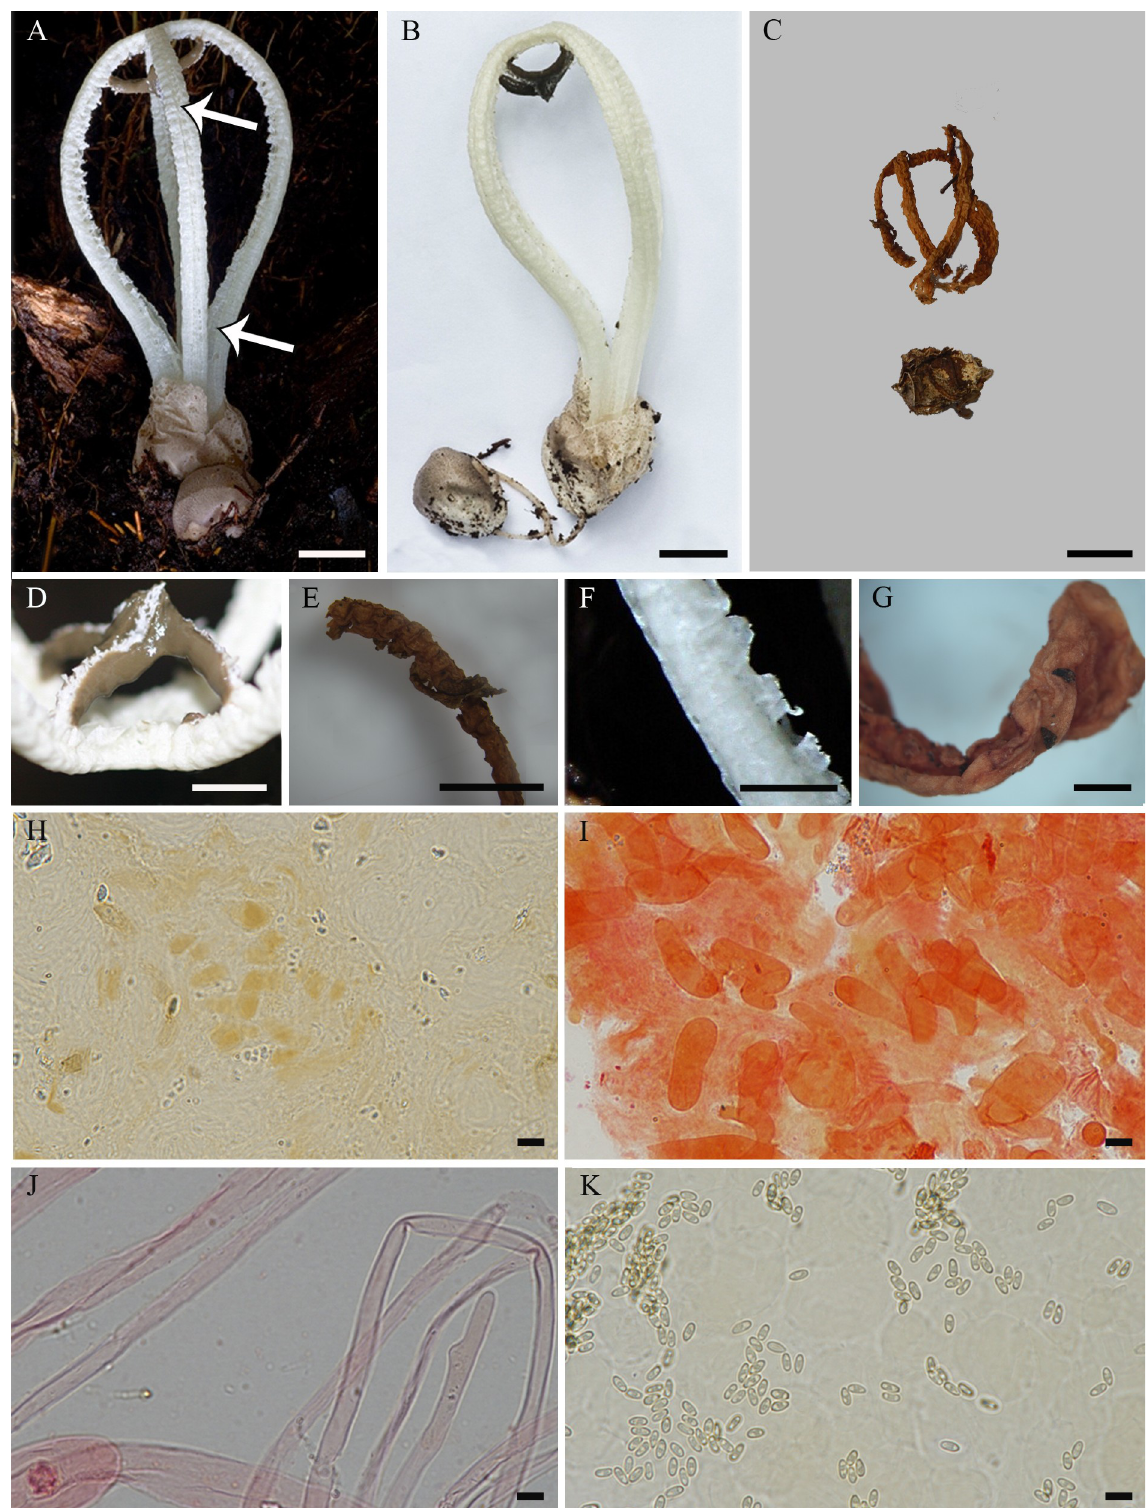
Fig 6. Blumenavia crucis-hellenicae sp. nov. (A, B) Fresh basidiomata, SMDB 18116, holotype. (C) Dry basidiomata, ICN 177268, paratype. (D, E) Glebifer as a cross-shaped pyramidal structure: (D) Fresh, SMDB 18116, holotype; (E) Dry stuck in one arm, ICN 177268, paratype.